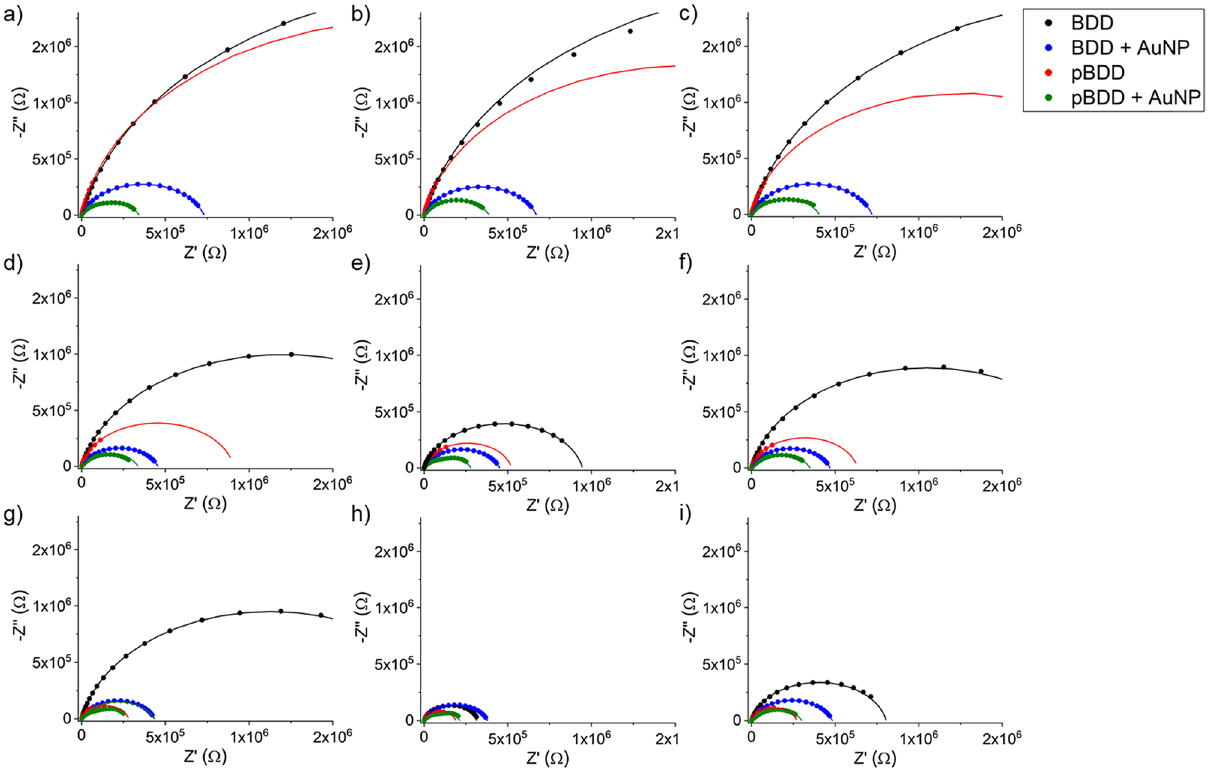
Figure 4. Nyquist plot presentation of the EIS data from measurements made over the frequency range 50 kHz to 50 MHz, with 8 points per decade and 10 mV amplitude, for each of the electrodes. The results presented here are from EIS measurements made at (a) open circuit potential, 1 µM Hg concentration, (b) deposition potential (0.35 V), 1 µM Hg concentration, (c) stripping potential (1.0 V), 1 µM Hg concentration, (d) open circuit potential, 500 µM Hg concentration, (e) deposition potential (0.35 V), 500 µM Hg concentration, (f) stripping potential (1.0 V), 500 µM Hg concentration, (g) open circuit potential, 1 mM Hg concentration, (h) deposition potential (0.35 V), 1 mM Hg concentration and (i) stripping potential (1.0 V), 1 mM Hg concentration. The Nyquist plots for the other mercury concentration and potentials tested with EIS are presented in the Supplementary Information.